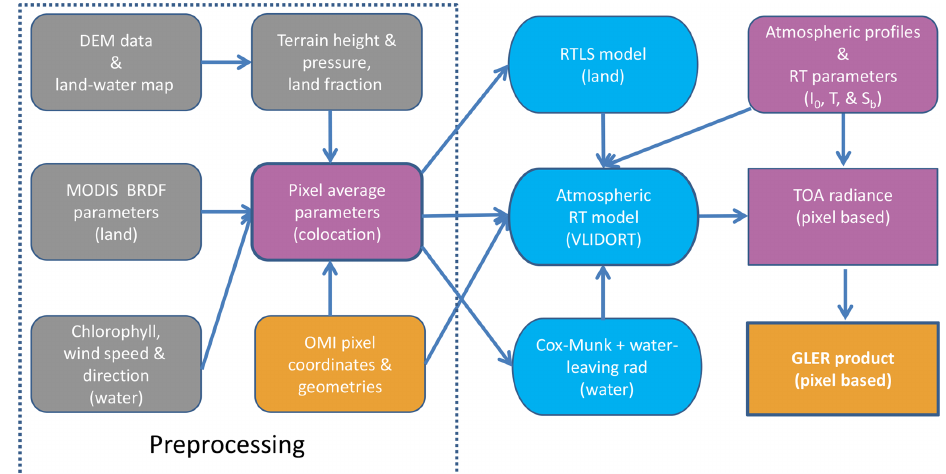
Figure 1. Flowchart of the GLER processes. Different colors stand for different data types/sources: grey for ancillary data for both land and water, purple for preprocessed input parameters or atmospheric input parameters, gold for sensor-dependent pixel-related inputs/output, and finally, blue ovals for the physical models used. All input data are represented by the rounded rectangles and output product is shown in the box rectangle. DEM denotes digital elevation model. RTLS denotes the Ross-thick/Li-sparse reciprocal functions (see Sect. 2.1 for details). Also see Eq. (2) for definitions of I 0 , T and S b